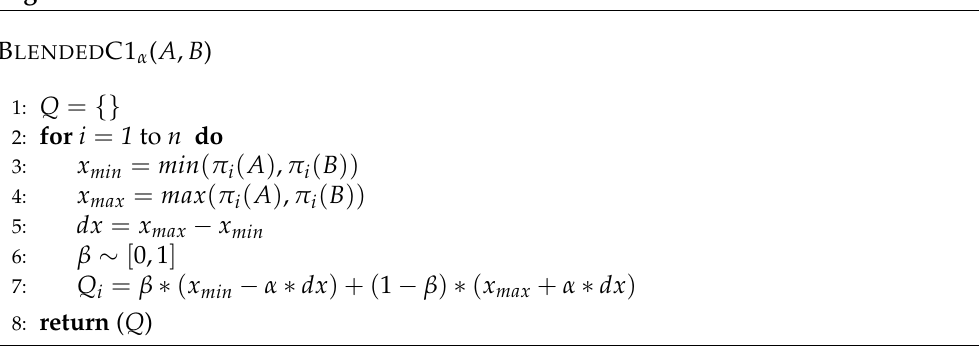
Algorithm 7 Blended Crossover-B LENDED C1